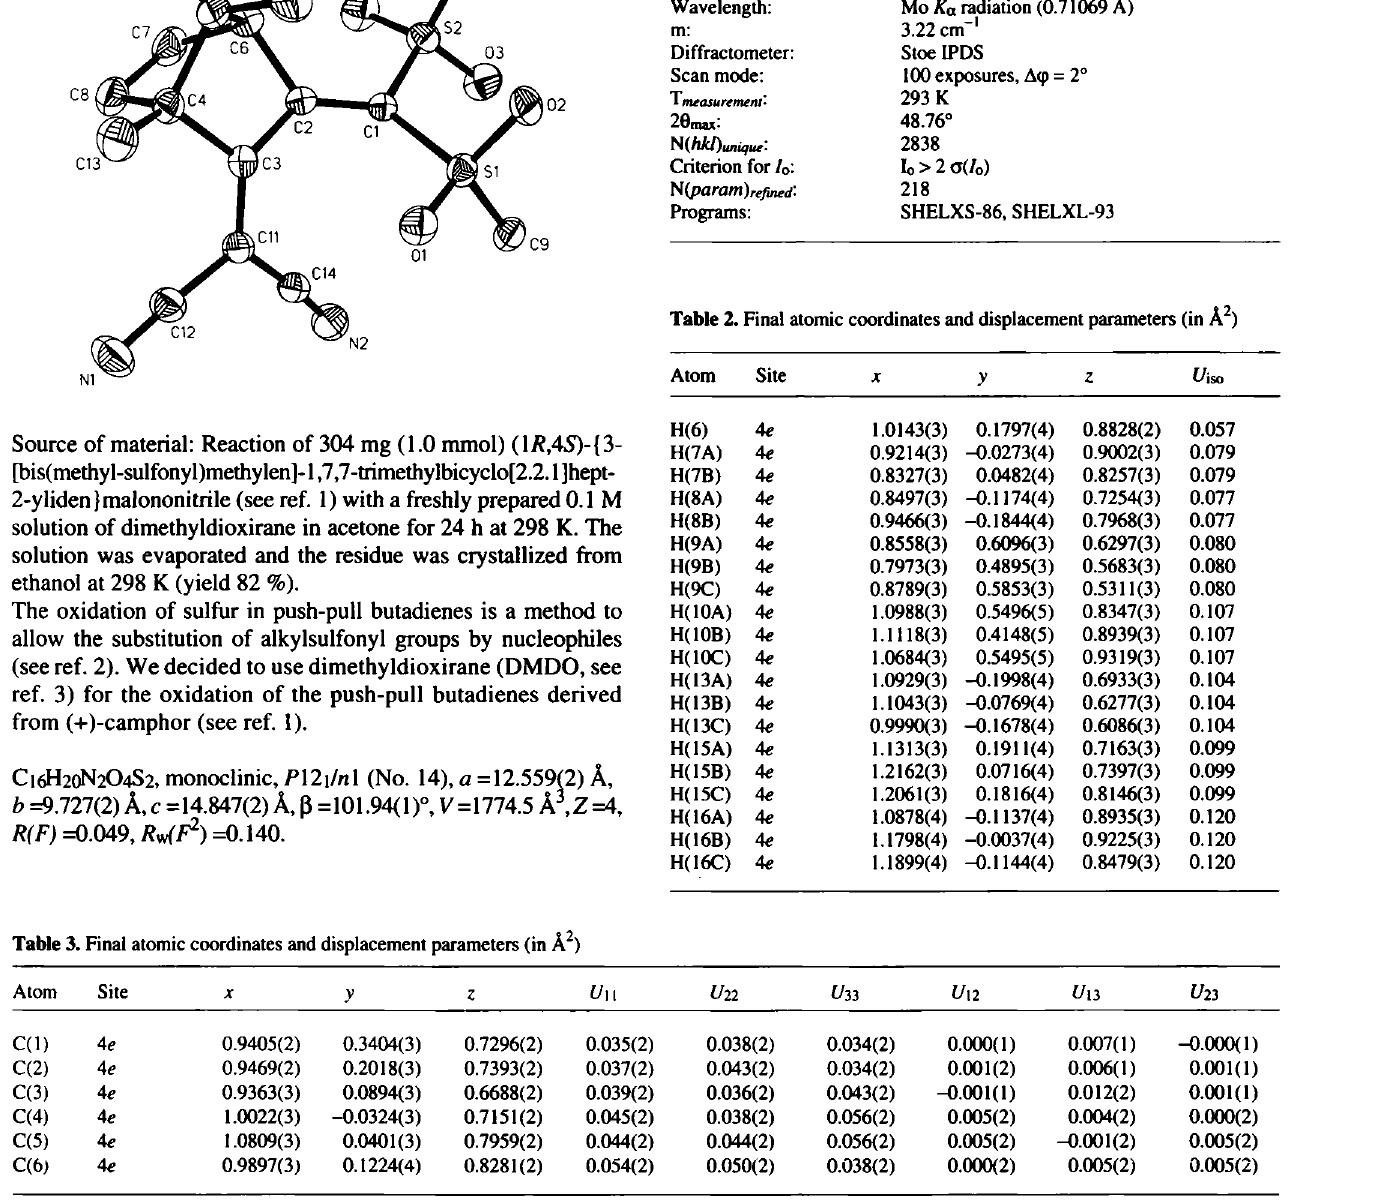
Table 1. Parameters used for the X-ray data collection Crystal: